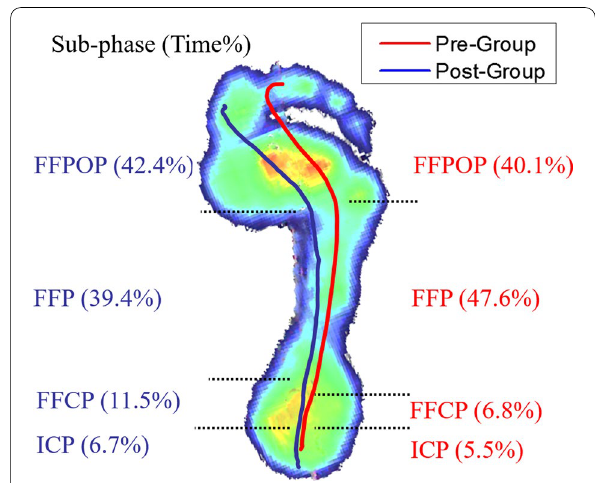
Table 3 Comparison of ML-COP displacement and velocity between the pre- and post-group. (Mean (SD))